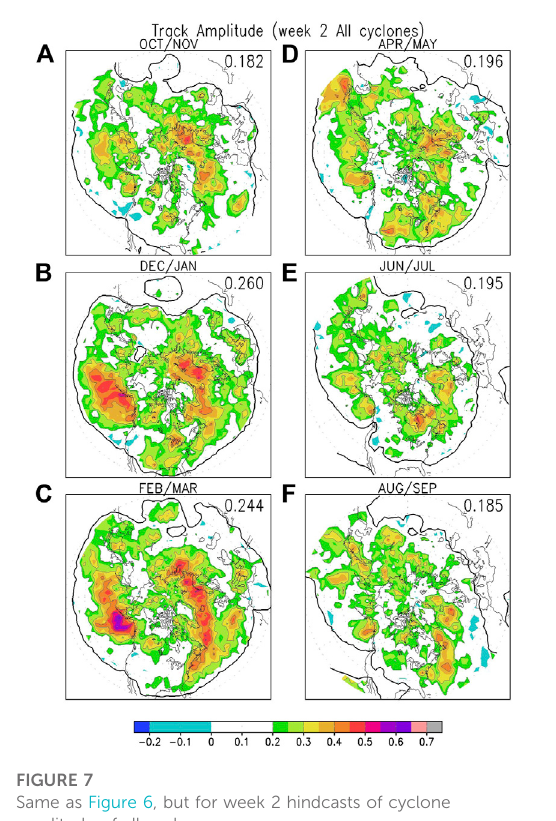
FIGURE 7 Same as Figure 6, but for week 2 hindcasts of cyclone amplitude of all